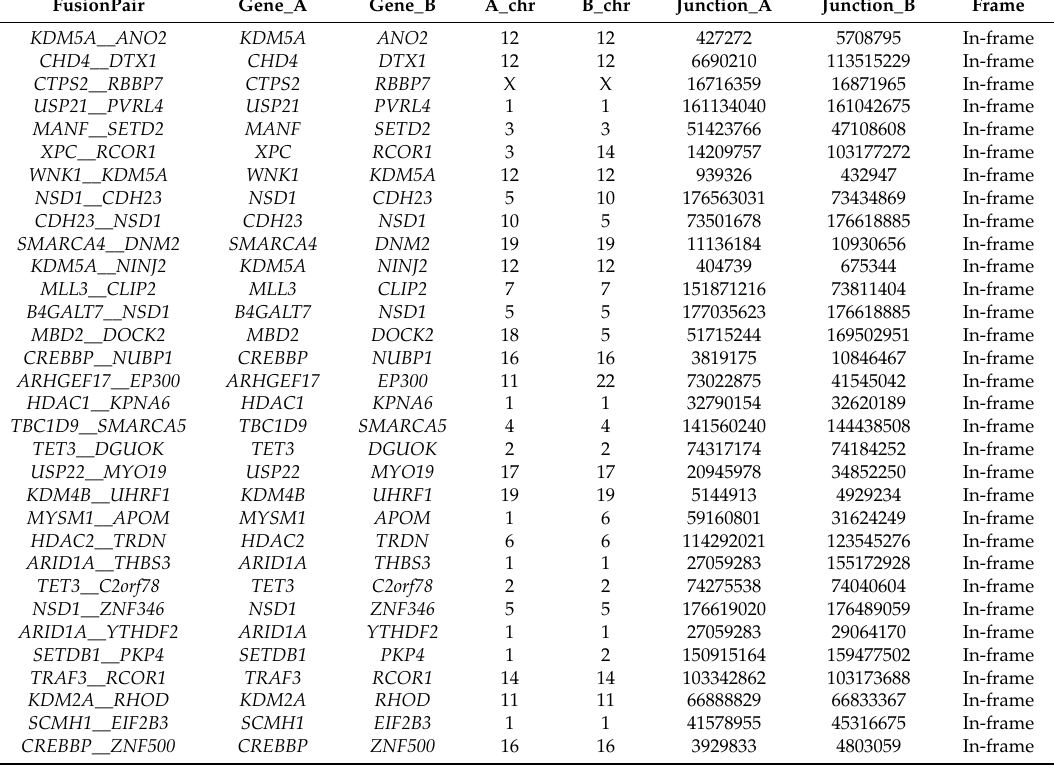
Table 2. Fusion Gene Transcripts involving Chromatin Modifier Genes in Breast